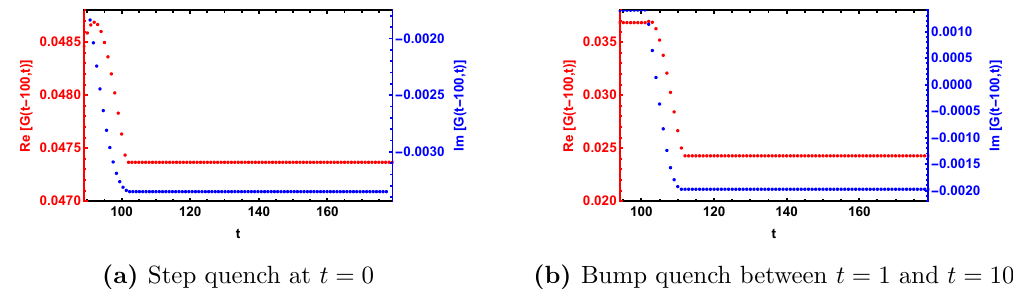
Figure 4. Plots of real and imaginary parts of G > ( t (cid:0) 100 ; t ) for (a) step quench, both the time arguments are outside the quench region for t > 100, and for (b) bump quench, both the time arguments are outside the quench region for t (cid:21) 111. As we can see, the greater Green’s function equilibrates instantaneously.